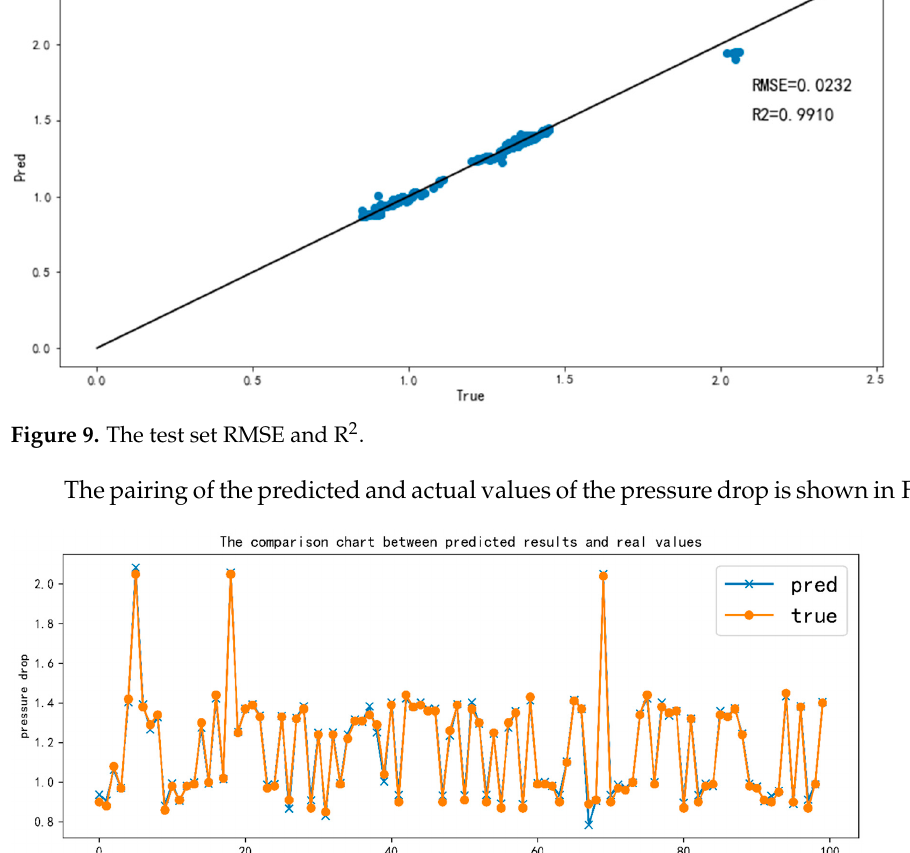
Figure 10. Comparison of predicted and real values.